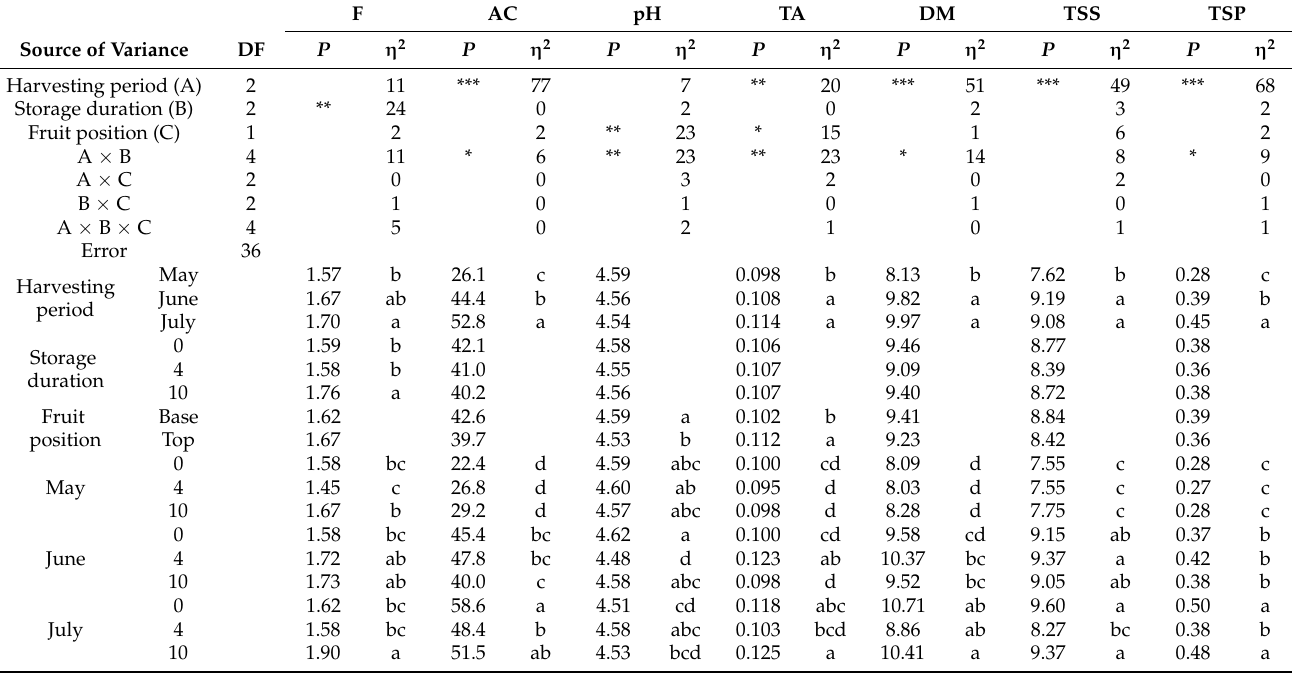
Table 2. ANOVA for firmness (F, kg), antioxidant capacity (AC, mg ascorbic acid equivalents/100 g f.w.), pH, titratable acidy (TA, % citric acid), dry matter (DM, %), total soluble solids (TSS, %) and total soluble phenols (TSP, mg gallic acid equivalents/g f.w.) of cherry tomato fruits harvested in three dates during the period of May–July and stored at 12 ◦ C for 0, 4 and 10 days. The fruits